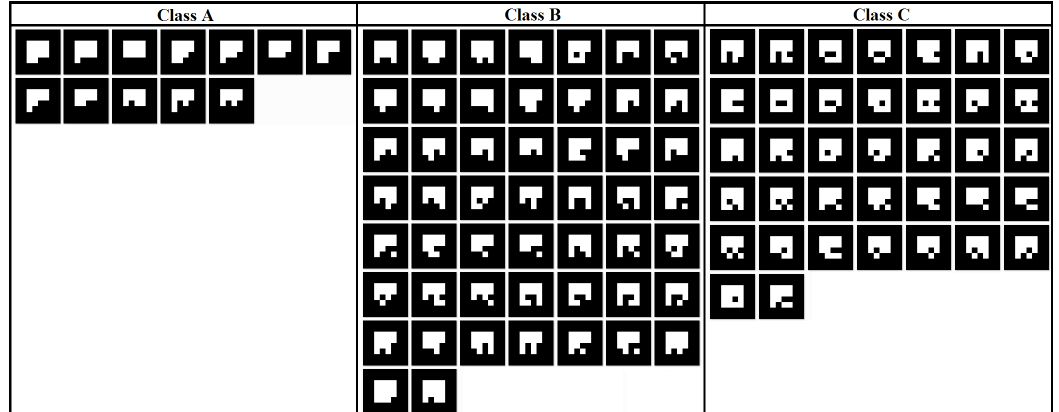
Fig 12. Markers classified into three classes according to the recognition efficiency: A class – most reliable; B class – reliable; C class – most